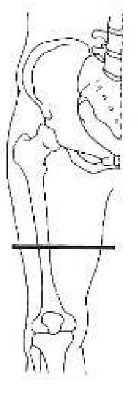
Figure 38. Trans-femoral amputation Figure 39. Above-knee amputation